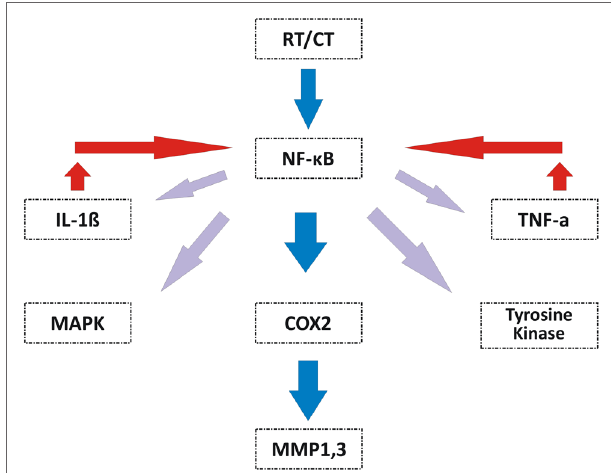
FiGuRe 3 | Signal amplification during OM induced by RT and/or CT (10) . Signal amplification during RT- and/or CT-induced OM is mediated by activation of NF- κ B that is reactivated by IL-1 β . NF- κ B induces the expression of genes responsible for the MAPK, COX-2, and tyrosine kinase pathways to finally activate the MMP1 and MMP3 signaling at the injured tissue cells. TNF- α , tumor necrosis factor- α ; IL-1 β , interleukin-1 β ; NF- κ B, nuclear factor- κ B; MAPK, mitogen-activated protein kinase; COX-2, cyclooxegenase-2; MMP1, matrix metalloproteinase 1; MMP3, matrix metalloproteinase 3; OM, oral mucositis; CT, chemotherapy. Republished with the permission of Dr. Sonis.